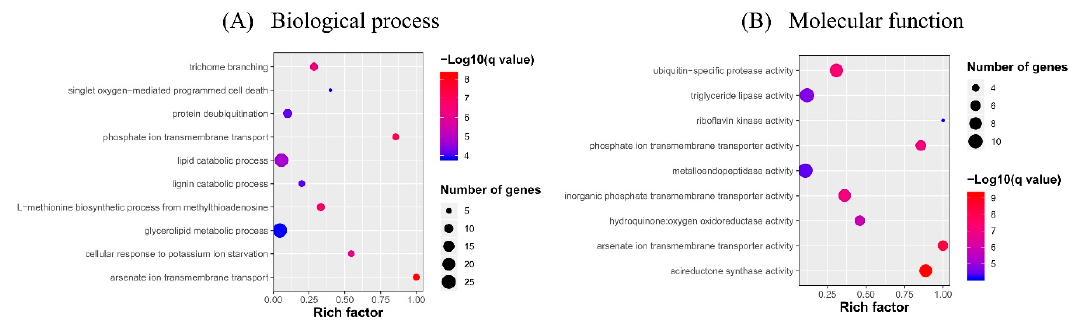
Figure 6. GO term enrichments of di ff erentially expressed lncRNAs (DELs) in response to AM fungus. ( A ) Biological process, ( B ) Molecular function.